Question: Identify the chart type used in this figure.
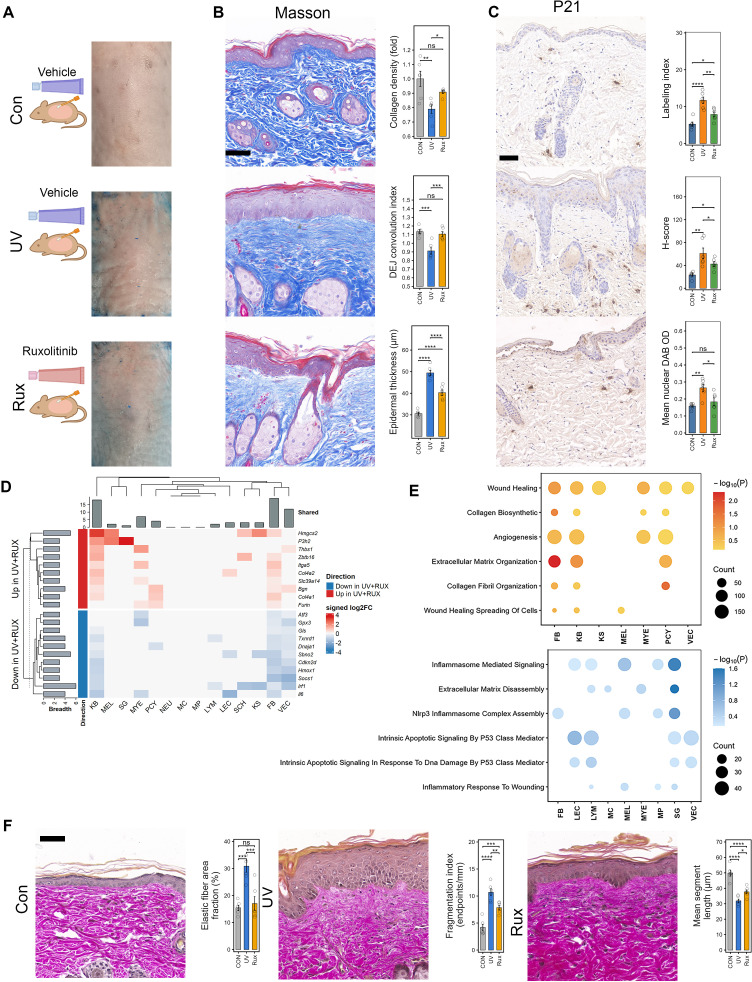
Answer: heatmap